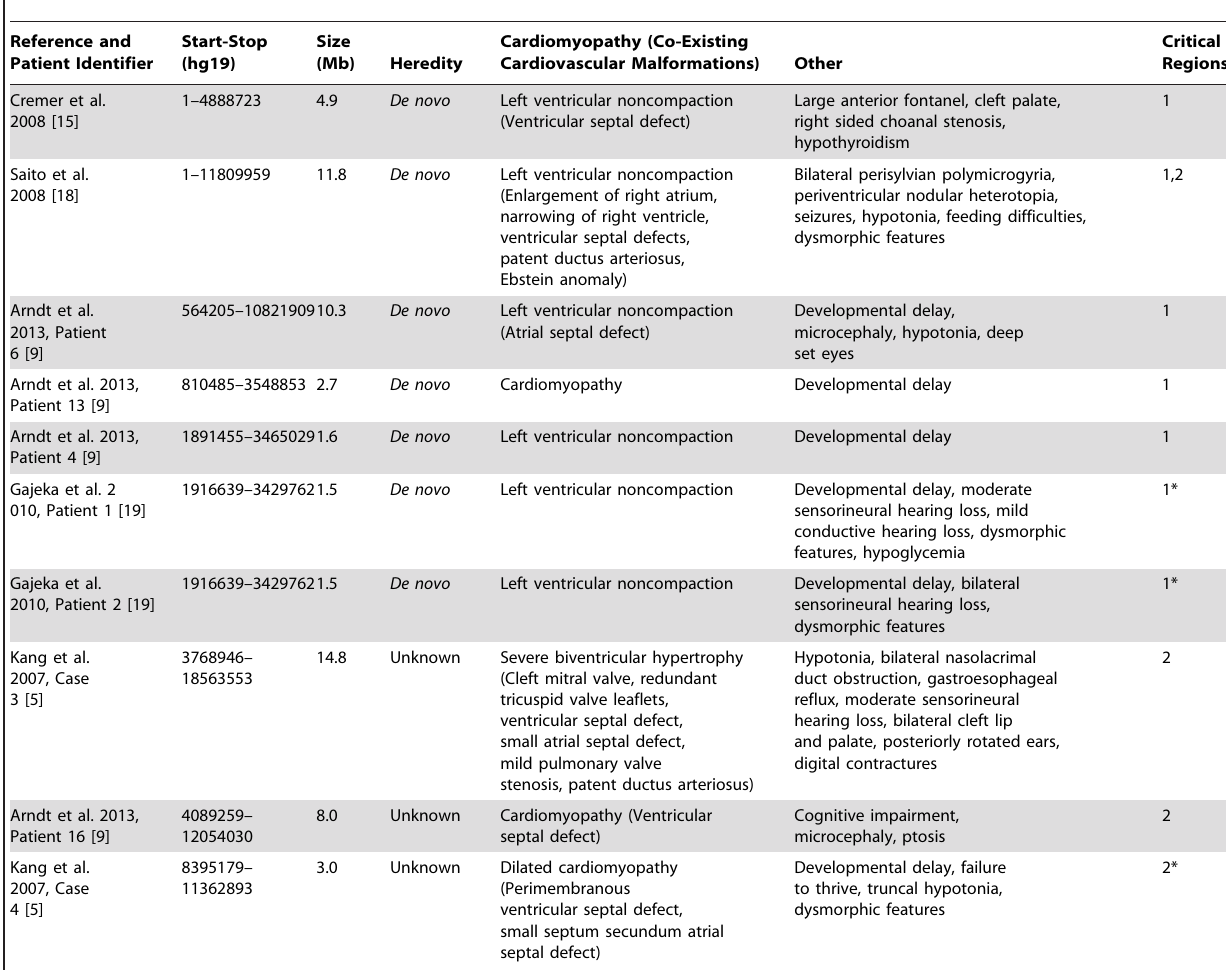
Table 6. Summary of individuals with isolated 1p36 deletions and cardiomyopathy identified from the literature.